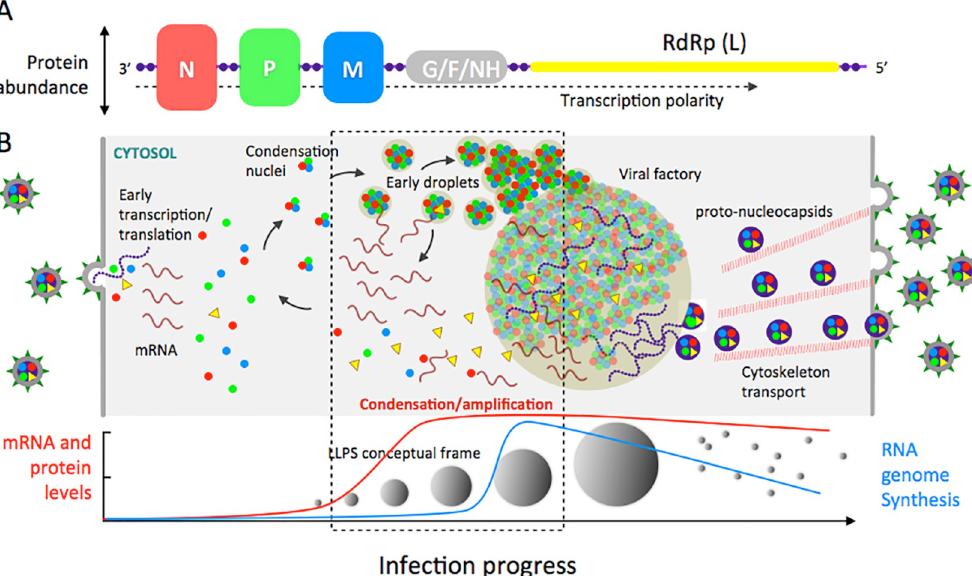
Fig 2. A general integrative model for condensation of VFs based on NSVs. (A) Simplified depiction of nsNSV genome structure. The viral transcription mechanism ensures a gradient of protein expression, with higher abundance of N, encoded at the 3 0 region, and lower abundance of the large polymerase, invariably encoded at the 5 0 end of nsNSV genomes. (B) Model depicting the formation of cytosolic VFs along viral infection. The schema stresses the amplification effect on RNA and protein synthesis caused by the self-primed formation of condensates (see main text). Toward the end of the infectious cycle, the immature nucleocapsids (proto-nucleocapsids) protrude from the VF and are transported along the cytoskeleton network to the assembly site [73]. The principle behind LLPS indicate that as the concentration of components increase, a partition into a newer denser phase takes place, where the concentration within the droplets remain constant, and further increase in the concentration of the components in the surrounding milieu cause an increment of the size of the condensates. The condensation event causes an abrupt increase of the effective local concentration of RNA and proteins, the drivers of the LLPS, which results in a substantial amplification of transcription and genome replication in the VF. LLPS, liquid–liquid phase separation; nsNSV, nonsegmented NSV; NSV, negative-stranded virus; RdRp, RNA-dependent RNA polymerase; VF, viral